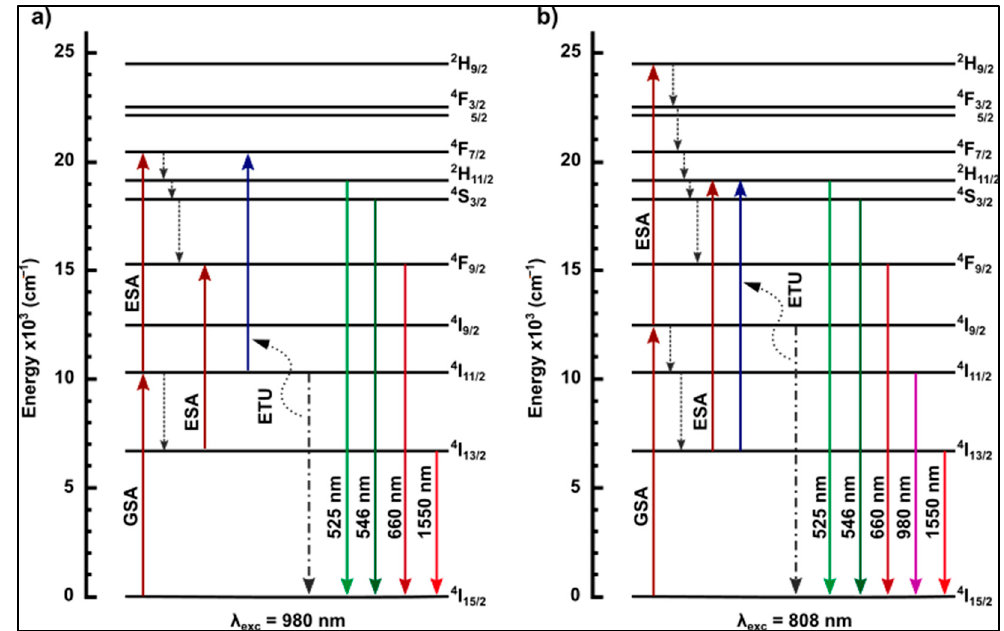
Figure 15. Energy level diagrams of Er 3+ -doped gallo-germanate glasses under laser excitation at ( a ) 980 nm and ( b ) 808 nm. GSA, ESA, non-radiative, and possible luminescence transitions have been indicated.